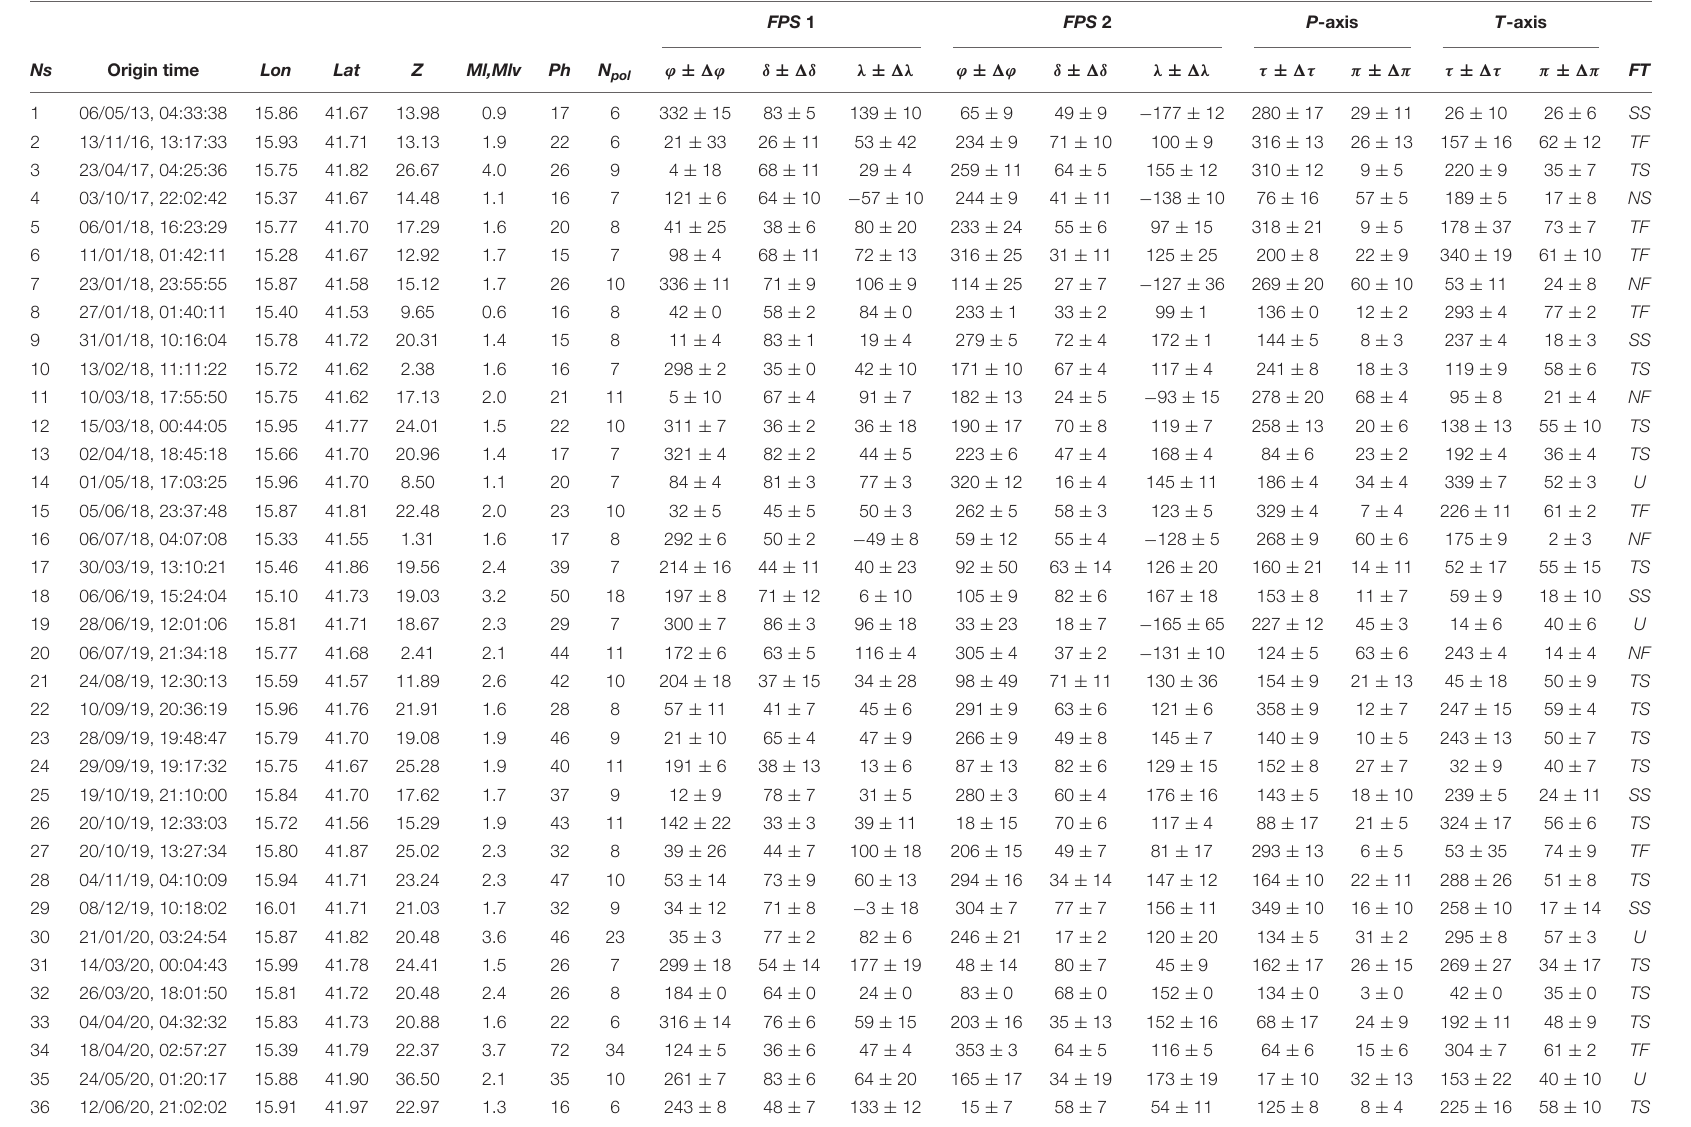
TABLE 1 | List of accepted focal mechanism